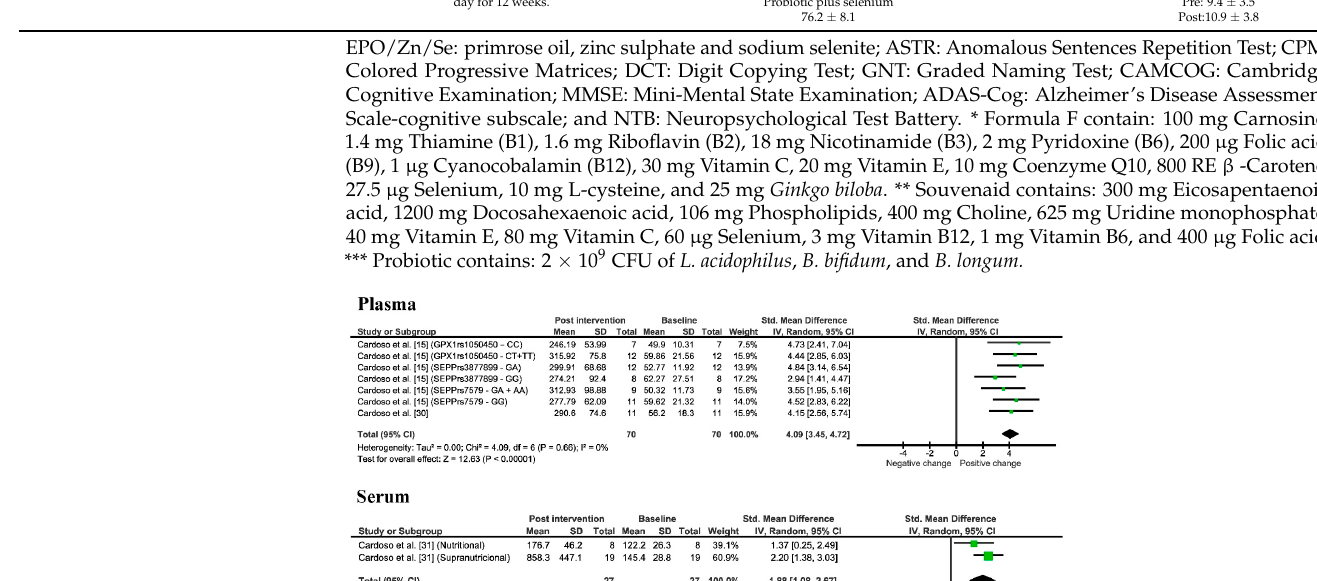
Placebo: placebo (starch)for12weeks. Selenium: 200mgofSe plusprobiotic***every dayfor12weeks.